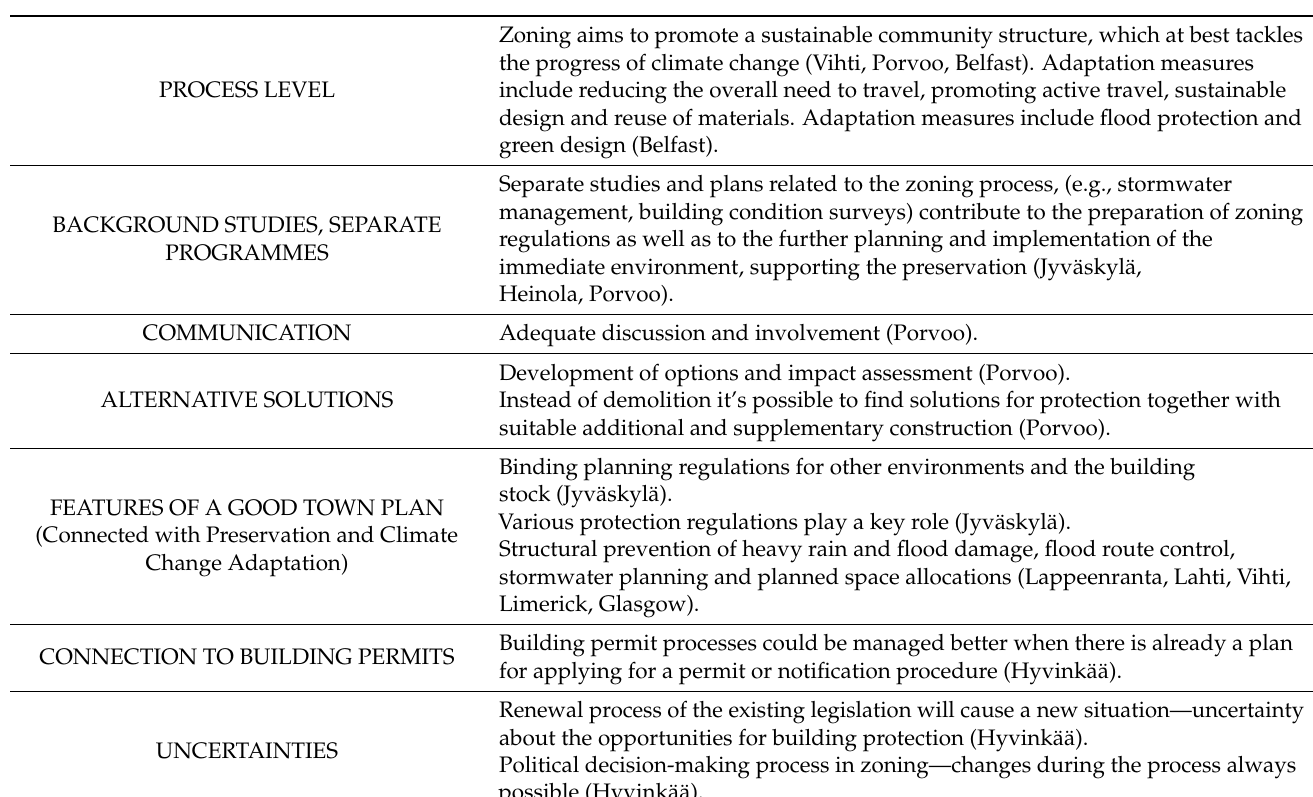
Table 5. The material from responses is grouped into different levels according to the general to detailed nature of the